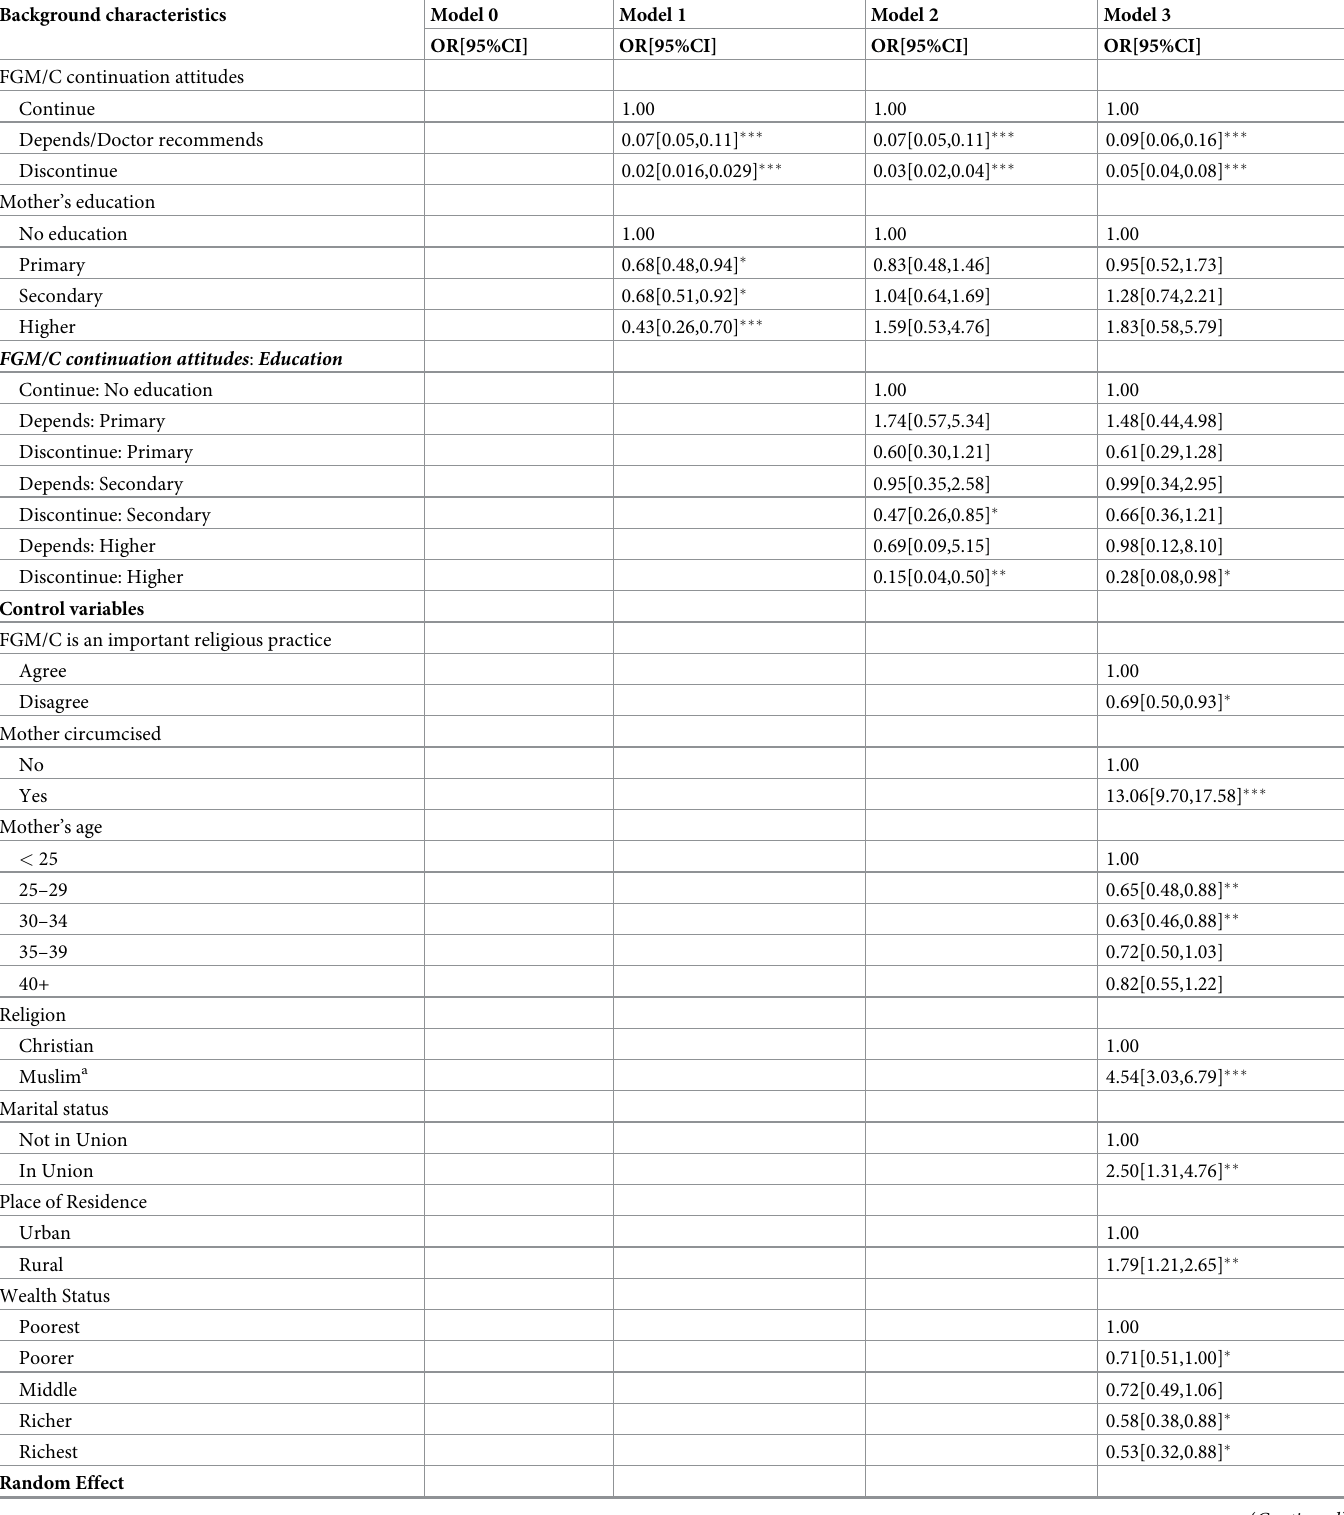
Table 2. Logistic regression results of circumcised daughters by background